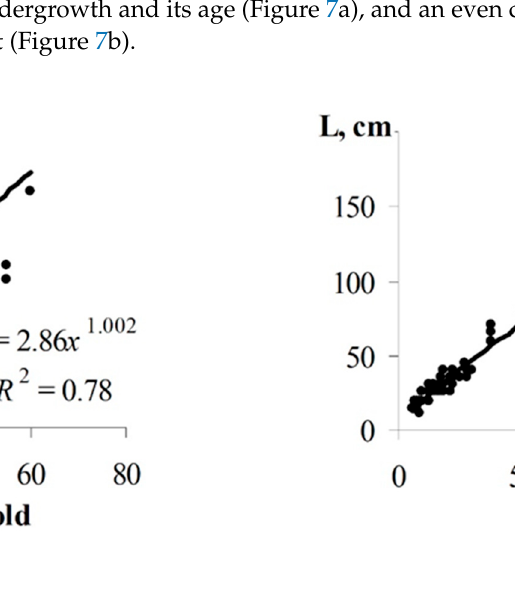
Figure 6. Samples of Pinus sibirica undergrowth: ( a ) Aged 10, 17 cm in height, average root length is 38 cm; ( b ) aged 12, 17 cm in height, average root length is 35 cm; photo taken by the authors.